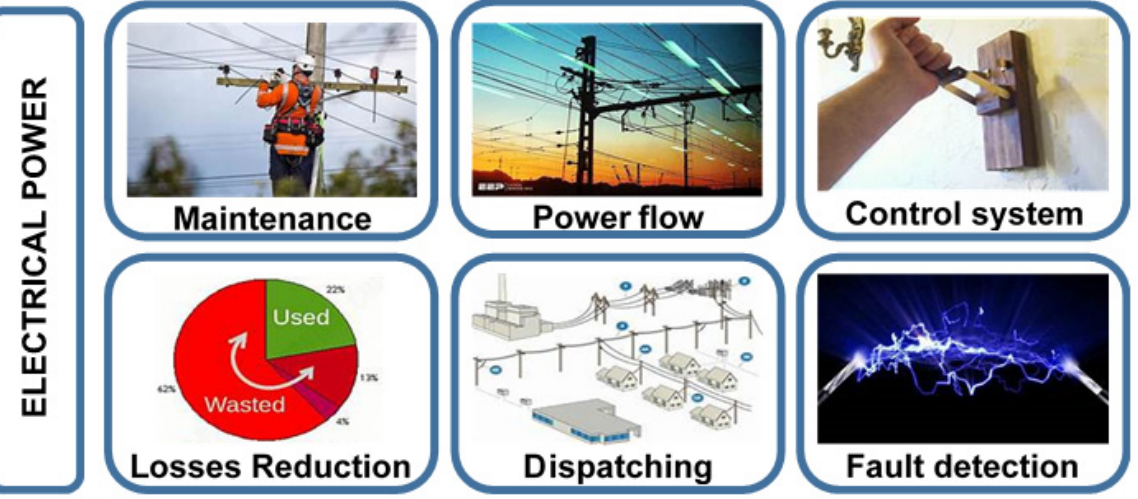
Figure 11. Electrical power networks topics.